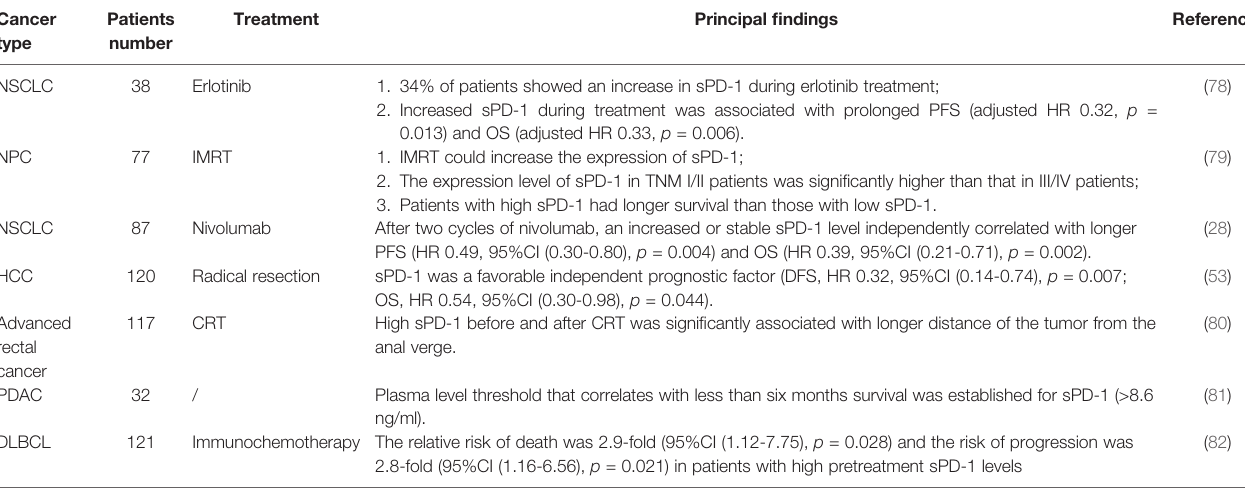
PD-1, soluble programmed death protein 1; NSCLC, non-small cell lung cancer; PFS, progression-free survival; HR, hazard ratio; OS, overall survival; NPC, nasopharyngeal carcinoma; IMRT, intensity-modulated radiation therapy; CI, con fi dence interval; HCC, hepatocellular carcinoma; DFS, disease-free survival; CRT, chemoradiotherapy; PDAC, pancreatic ductal adenocarcinoma; DLBCL, diffuse large B-cell